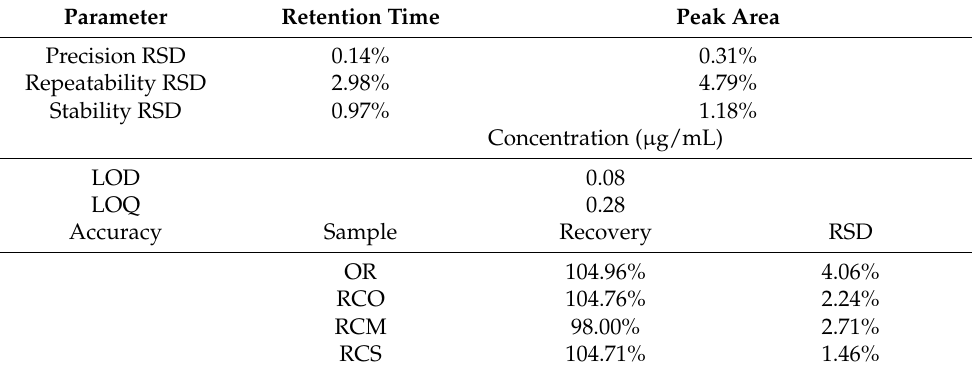
Table 2. Methodological validation of pre-column derivatization of 1-methyl hydantoin combined with